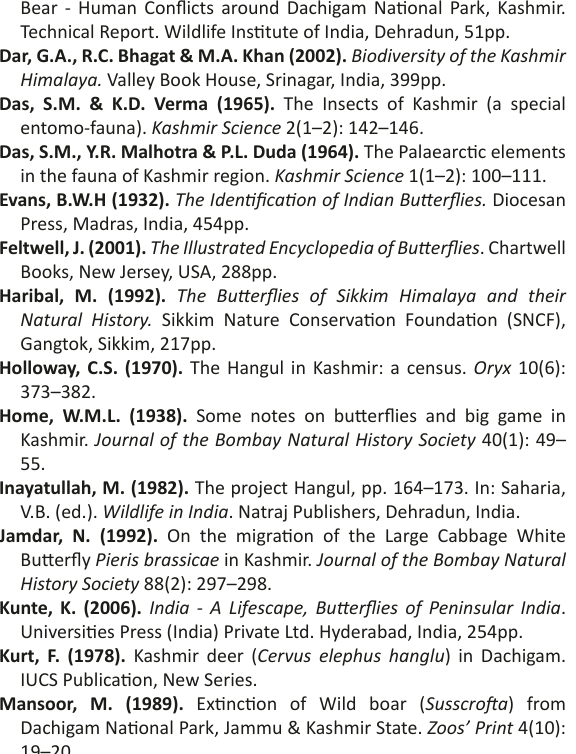
Table 1. Butterflies of Dachigam National